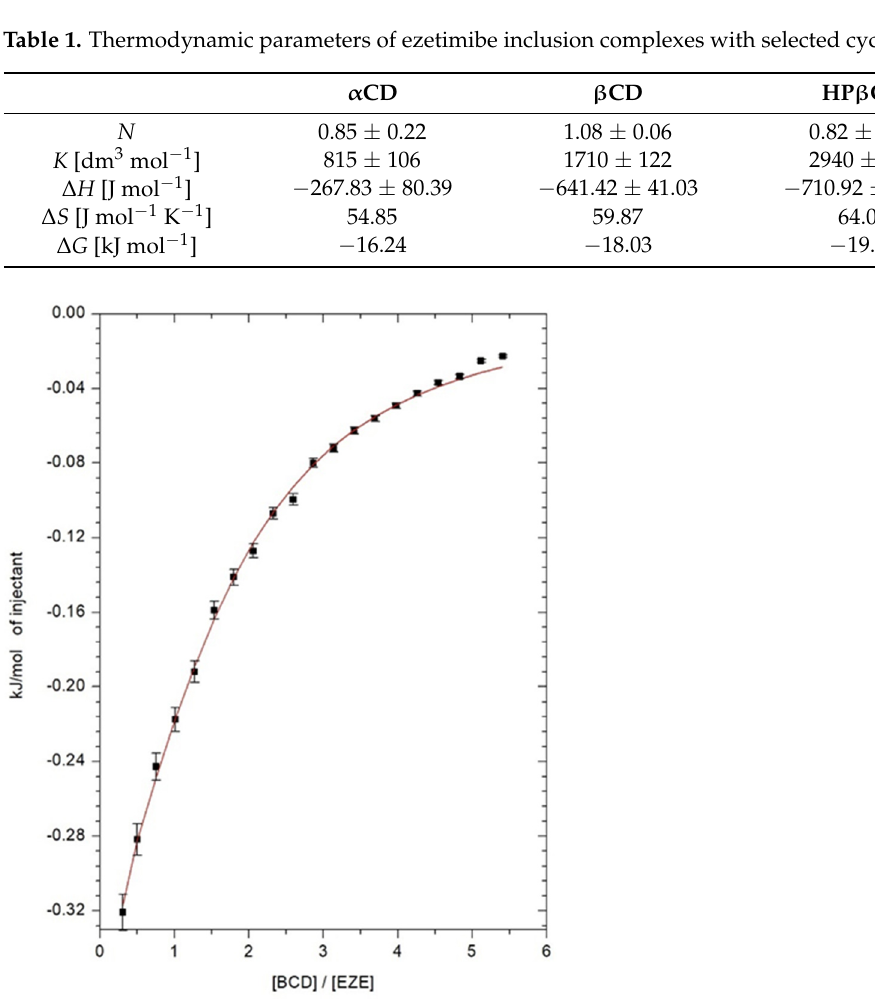
Figure 2. Direct effects of interaction between 0.5 mM ezetimibe and 14.2 mM α Figure 3. Direct effects of interaction between 0.5 mM ezetimibe and 14.2 mM β -cyclodextrin.